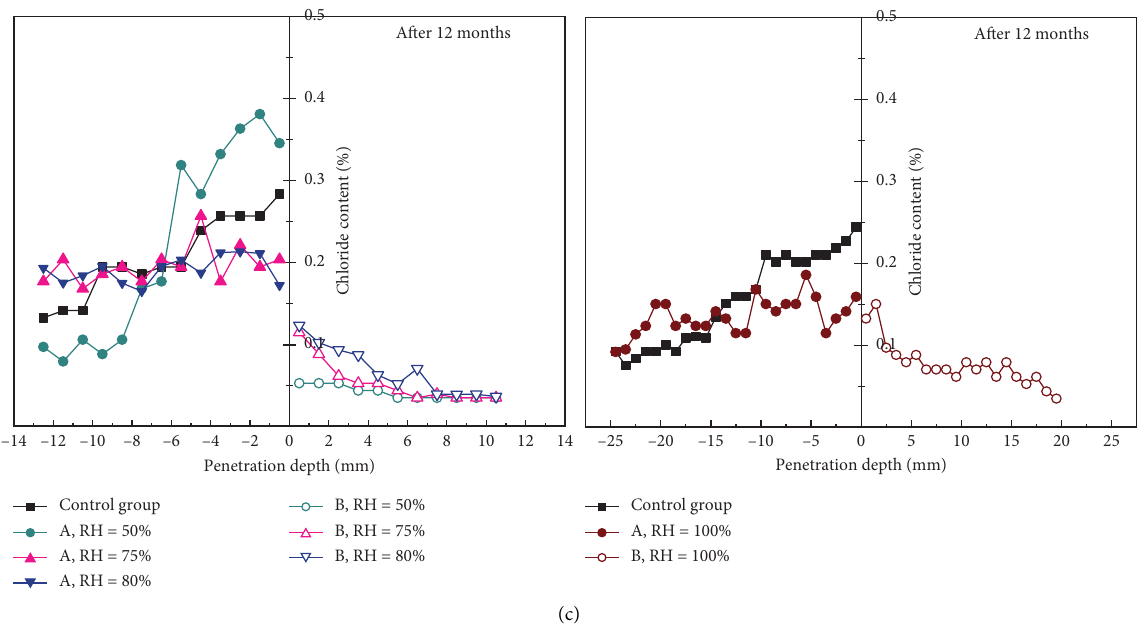
Figure 5: Chloride content curves of concrete with various exposure durations (w/c � 0.5). (a) 1 month, (b) 6 months, and (c) 12 months.